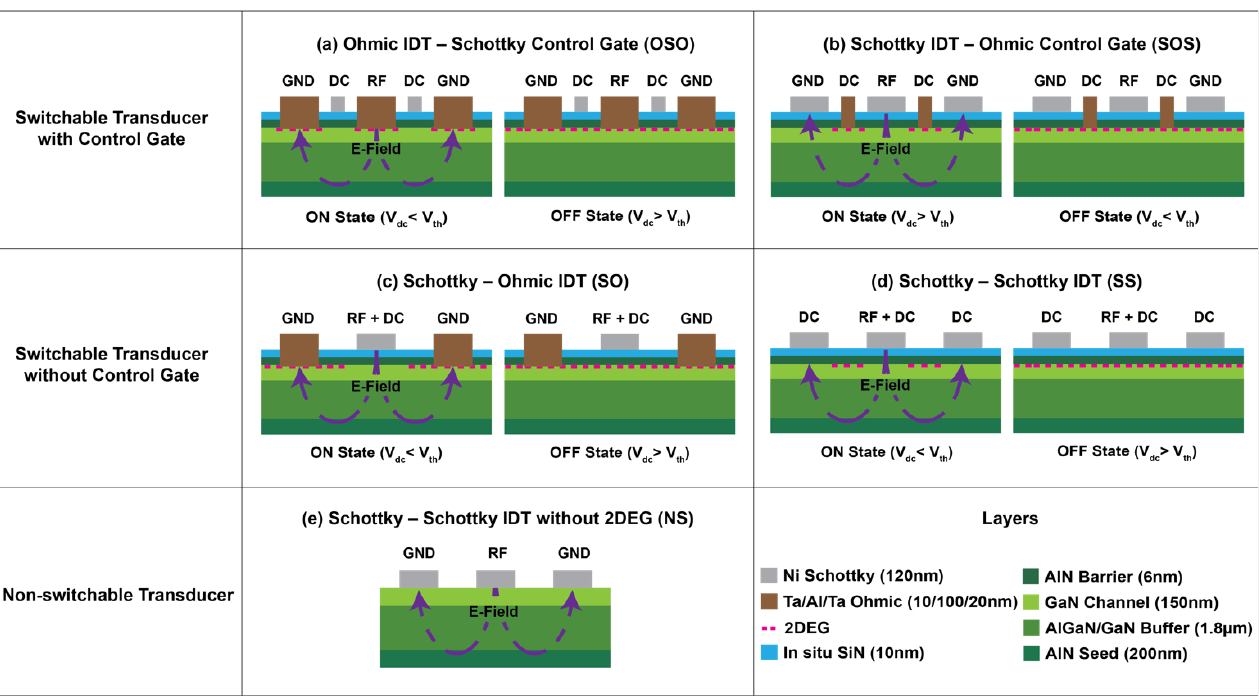
Figure 1. Schematic cross sections of different transducers considered in this work. Switchable transducer with ( a ) Ohmic – Ohmic IDT and Schottky control gate (OSO), ( b ) Schottky – Schottky IDT and Ohmic control gate (SOS), ( c ) Schottky – Ohmic IDT and no control gate (SO), ( d ) Schottky – Schottky IDT and no control gate (SS).( e ) Non-switchable (NS) transducer with Schottky – Schottky IDT and no 2DEG channel.